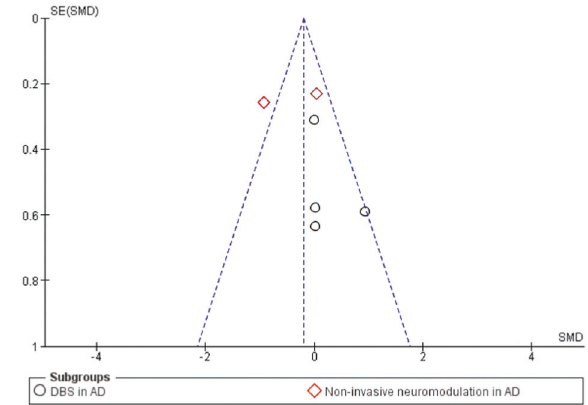
Fig. 4 Funnel plot of study data showing publication bias against small negative studies. AD Alzheimer ’ s disease, DBS deep brain stimulation, SE standard error, SMD standardized mean